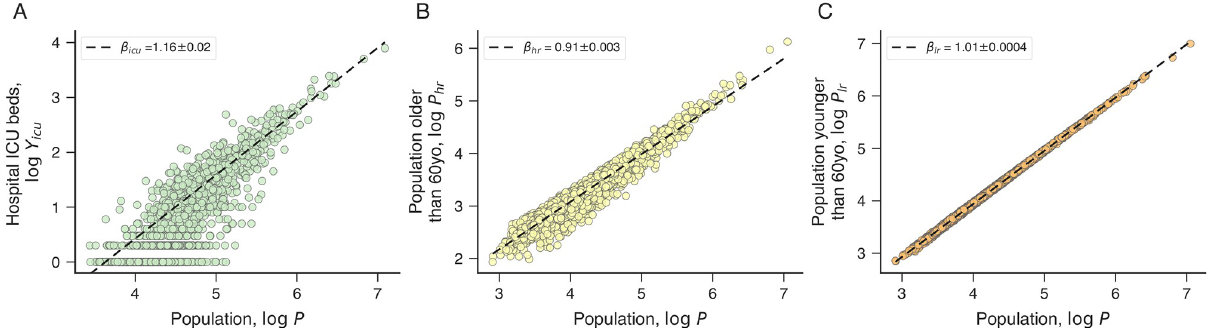
Fig 3. Urban scaling of ICU beds, high-risk and low-risk populations. (A) Relationship between the number of ICU beds ( Y ) and the city icu population ( P ) on logarithmic scale. We observe that the number of ICU beds scales super-linearly with city size ( β icu = 1.16 ± 0.02), indicating an urban advantage for health coverage. (B) Relationship between the high-risk population ( P , defined as adults older than 60 years) and the city population ( P ) hr on logarithmic scale. The high-risk population scales sub-linearly ( β hr = 0.910 ± 0.003), showing that large cities tend to have smaller fractions of elderly than small cities. (C) Relationship between low-risk population ( P , defined as adults younger than 60 years) and the city population ( P ) on logarithmic lr scale. We note that the low-risk population scales almost linearly ( β hr = 1.0100 ± 0.0004) with city size. The behavior of these three quantities partially explains the initial decrease of number of deaths per capita with population ( β d < 1 for t d ≲ 100 days). See Fig 15 in S1 Appendix for the scaling relations involving per capita